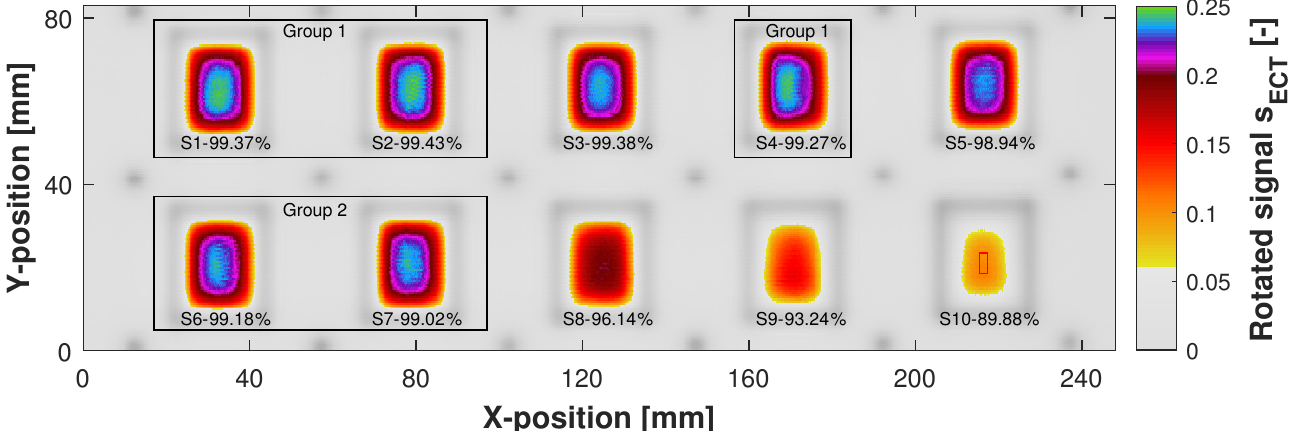
Figure 4. Image obtained from the 2D scan of the 316L parts. The data contain the rotated signal mapped to the X and Y positions of the sensor during the raster scan, as described in Section 2.3. Below each part, the part description and relative density are presented. Non-significant differences between mean rotated signals of samples are indicated by grouping the respective parts. One sample used for the statistical analysis obtained from the central region of the part 2 × 5 mm 2 (X × Y) is highlighted with a red rectangle on part